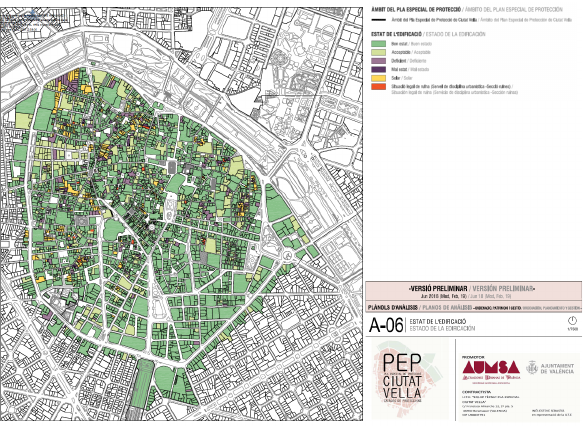
Figure 12. Structure plans, Gran Via Marqués del Turia Avenue, (Source: Rieta Sister, 1929, UPV-